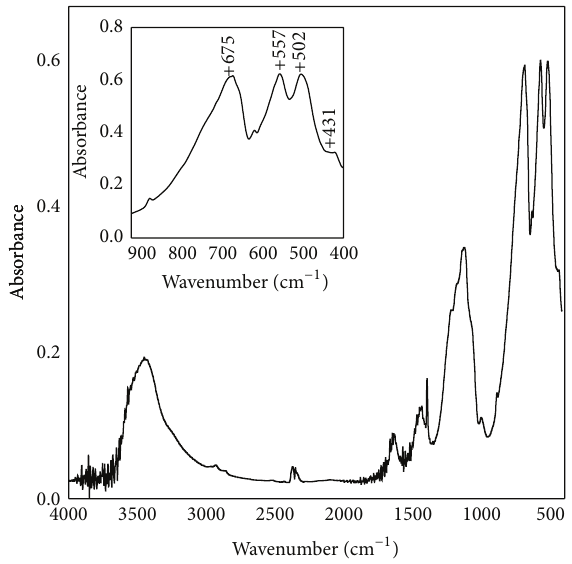
Figure 4: FTIR absorption spectrum of the ZnO/ZnAl 2 O 4 - deposited USP system and heat treated at 700 ∘ C for 1h.